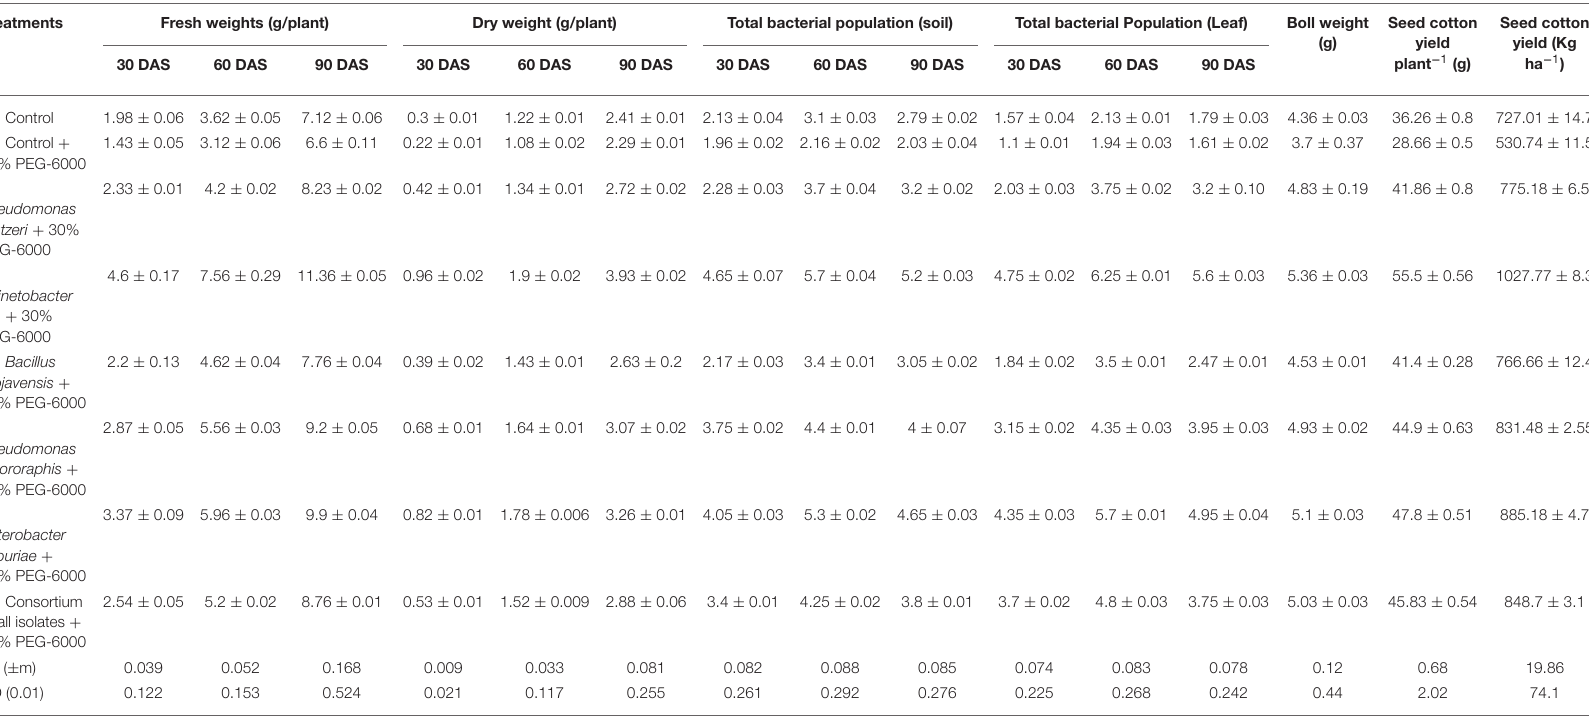
Efficient phyllosphere bacteria positively influenced the bacterial population in soil and